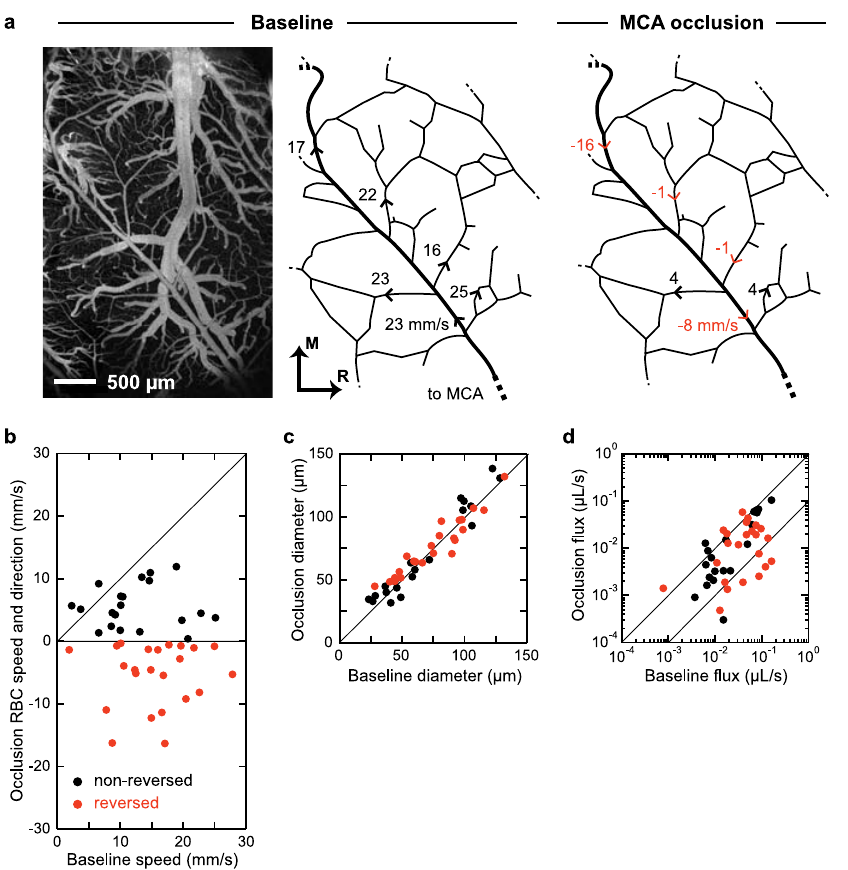
Figure 7. Quantitative Measurements of Flow Changes in Cortical Arterioles after Filament Occlusion of the MCA (A) Example of flow changes observed following MCA occlusion. Left: projection of a TPLSM image stack taken at baseline. Center: tracing of the surface arteriole network from the image with the baseline blood flow speed and direction indicated in some vessels. Right: blood flow speed and direction during MCA occlusion. Red arrows and speed labels indicate vessels whose direction has reversed. The axes indicate the rostral (R) and medial (M) directions. (B–D) RBC speed, vessel diameter, and volume blood flux, respectively, during MCA occlusion as a function of baseline values. The baseline and occlusion values of the diameter and flux are significantly correlated ( p , 0.005), with r 2 ¼ 0.92 and 0.26, respectively; the baseline and occlusion values of the speed are not significantly correlated. DOI: